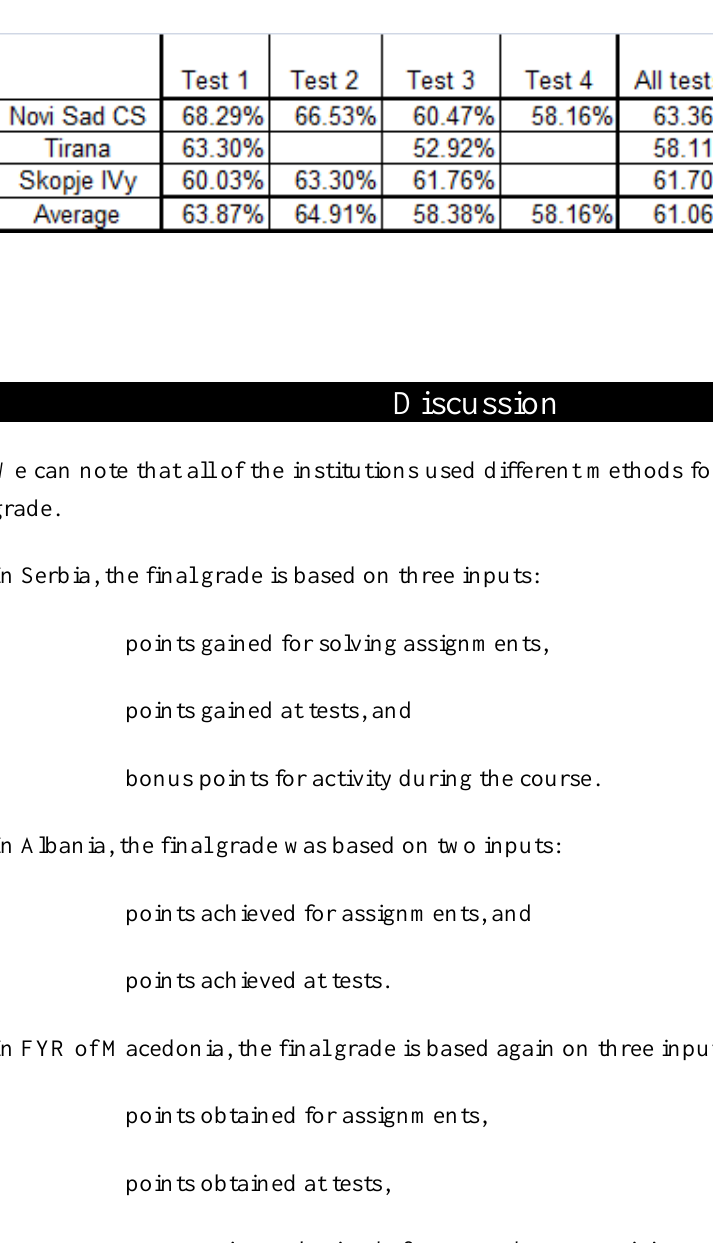
Final Test Percentages for the Final Year students of CS Programme from Different